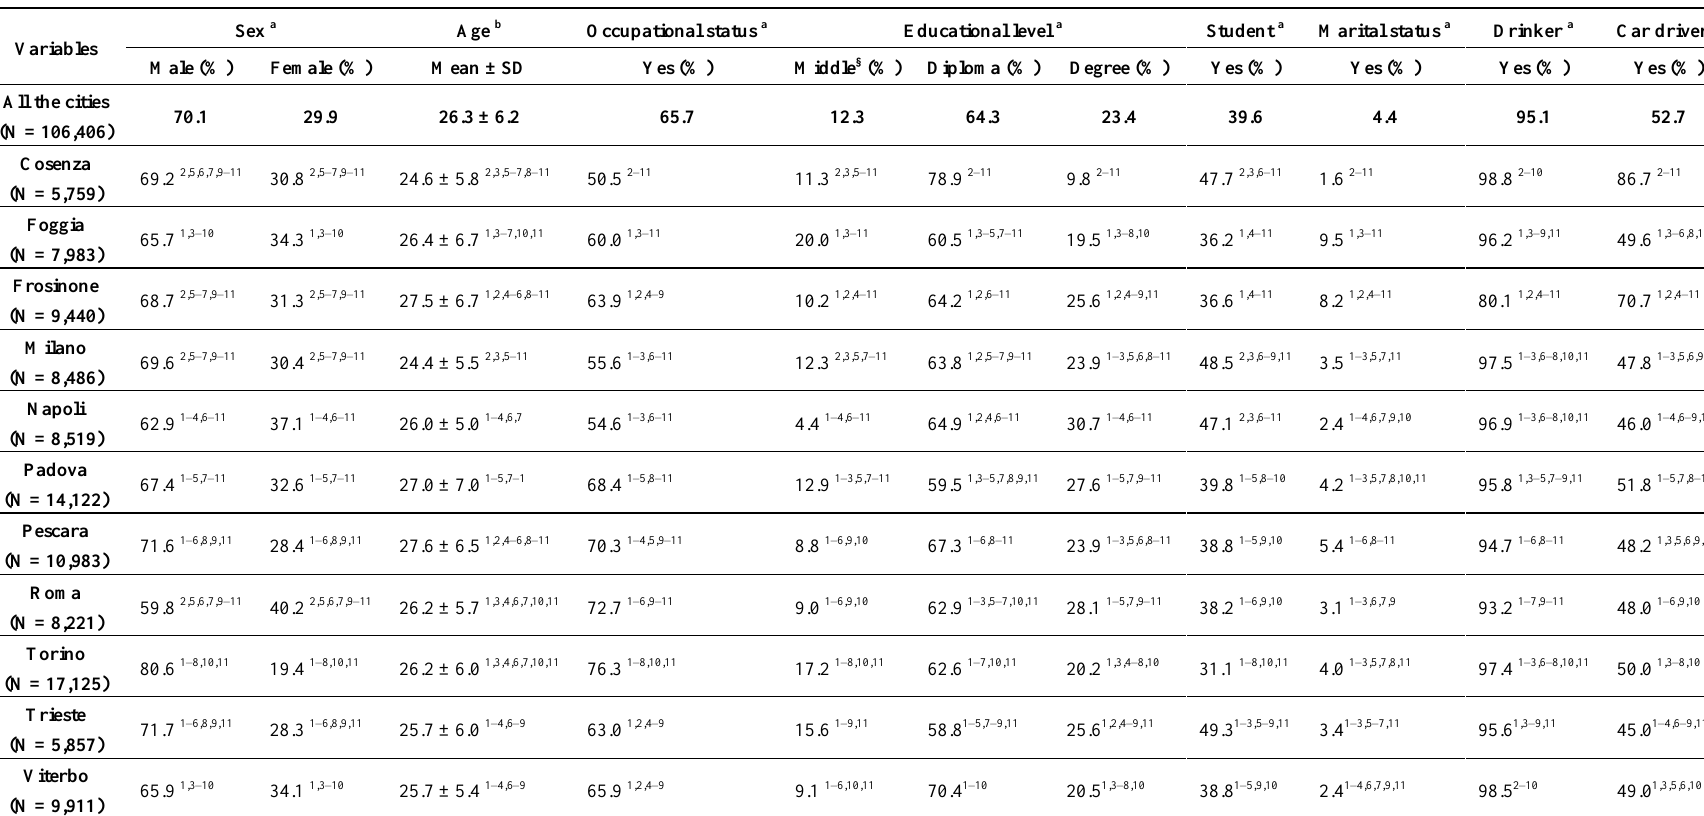
Table 1. Sociodemographic and environmental characteristics of all the participants, according to the city where they were enrolled.